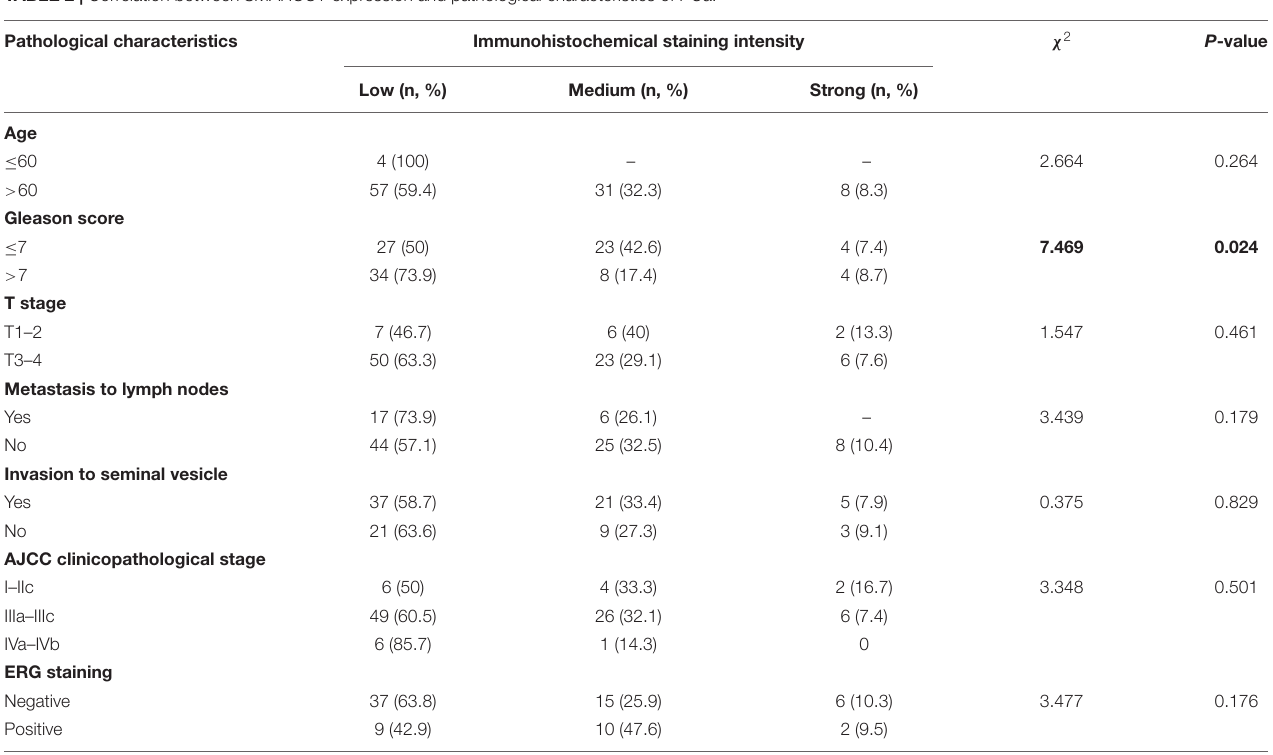
TABLE 2 | Correlation between SMARCC1 expression and pathological characteristics of PCa. Pathological